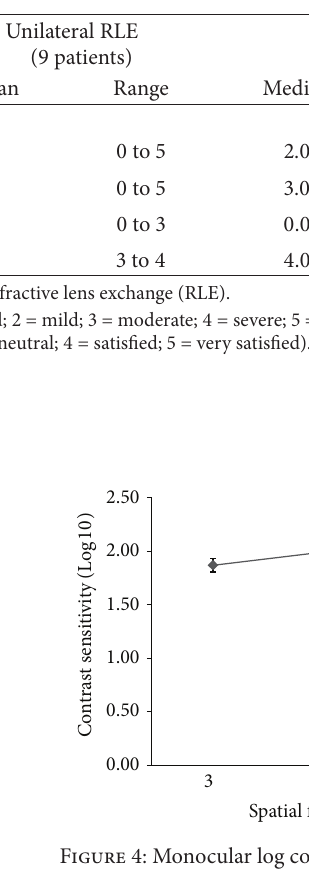
Table 2: Visual symptoms and satisfaction at 6 months.